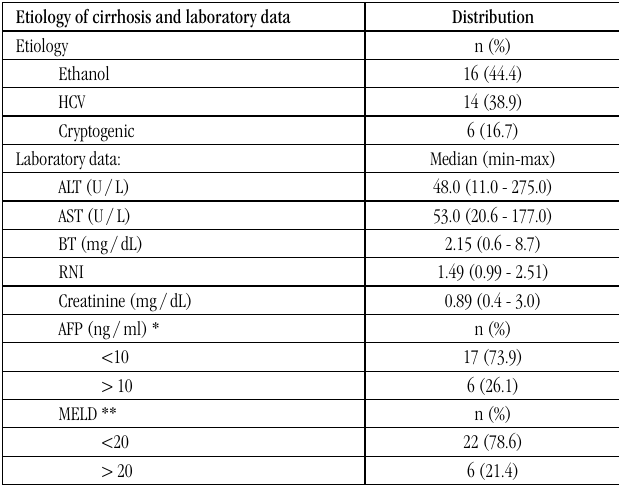
TABLE 1 - Distribution of Etiology of cirrhosis and laboratory data on patients undergoing liver transplantation at HC-UFMG between 2003 and 2015 Etiology of cirrhosis and laboratory